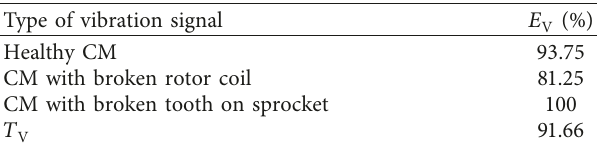
Table 3: The results of recognition of vibration signals—the MSAF- RATIO-50-SFC and the NM classifier were used.